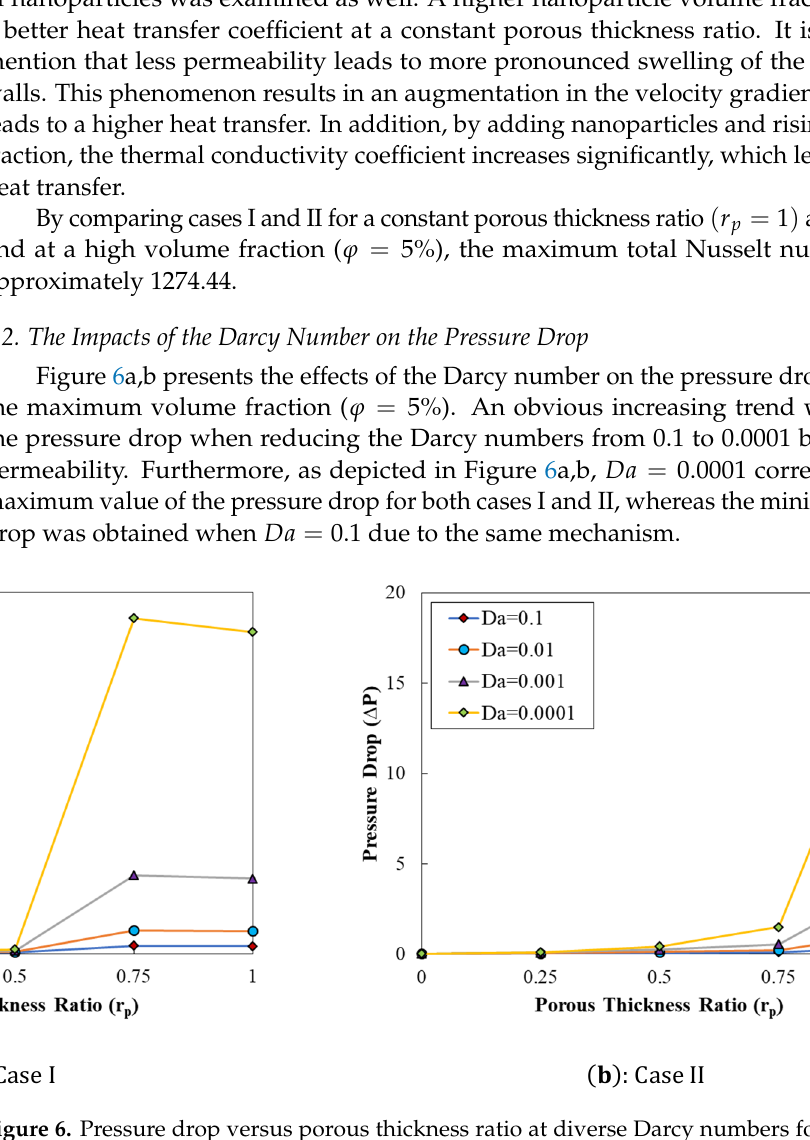
Figure 5. Total Nusselt number versus porous thickness ratio for diverse volume fractions at differ- ent Darcy numbers (case II) .